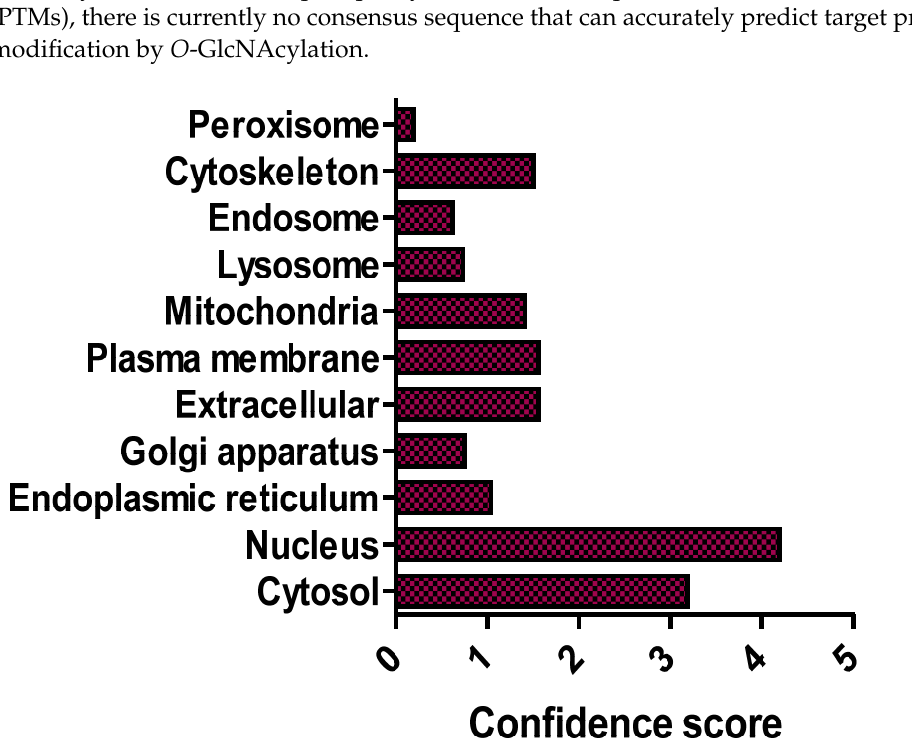
Figure 2. Subcellular distribution of the O -GlcNAcome. Median confidence scores of human O -GlcNAcylated proteins ( n = 4969) are from [22].